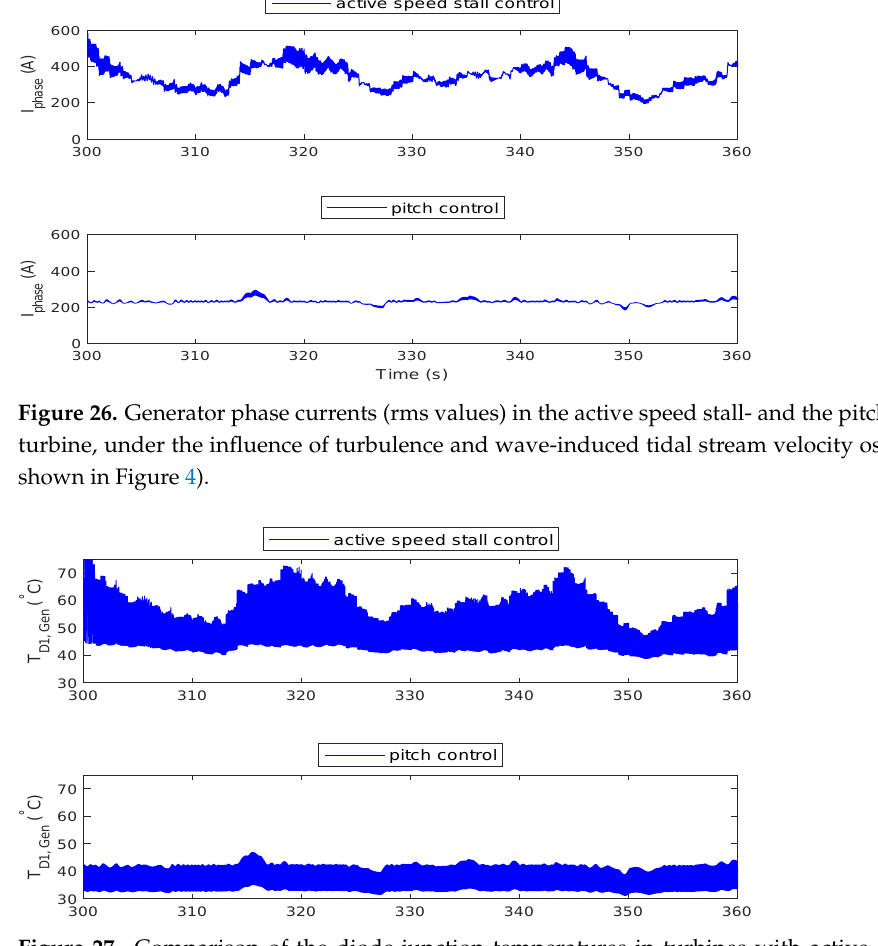
Figure 27. Comparison of the diode junction temperatures in turbines with active stall control and pitch control. It is clearly seen that pitch control mitigates the diode temperature cycling by maintaining nearly the same current even under significant wave-induced oscillations by virtue of maintaining nearly the same generator speed.